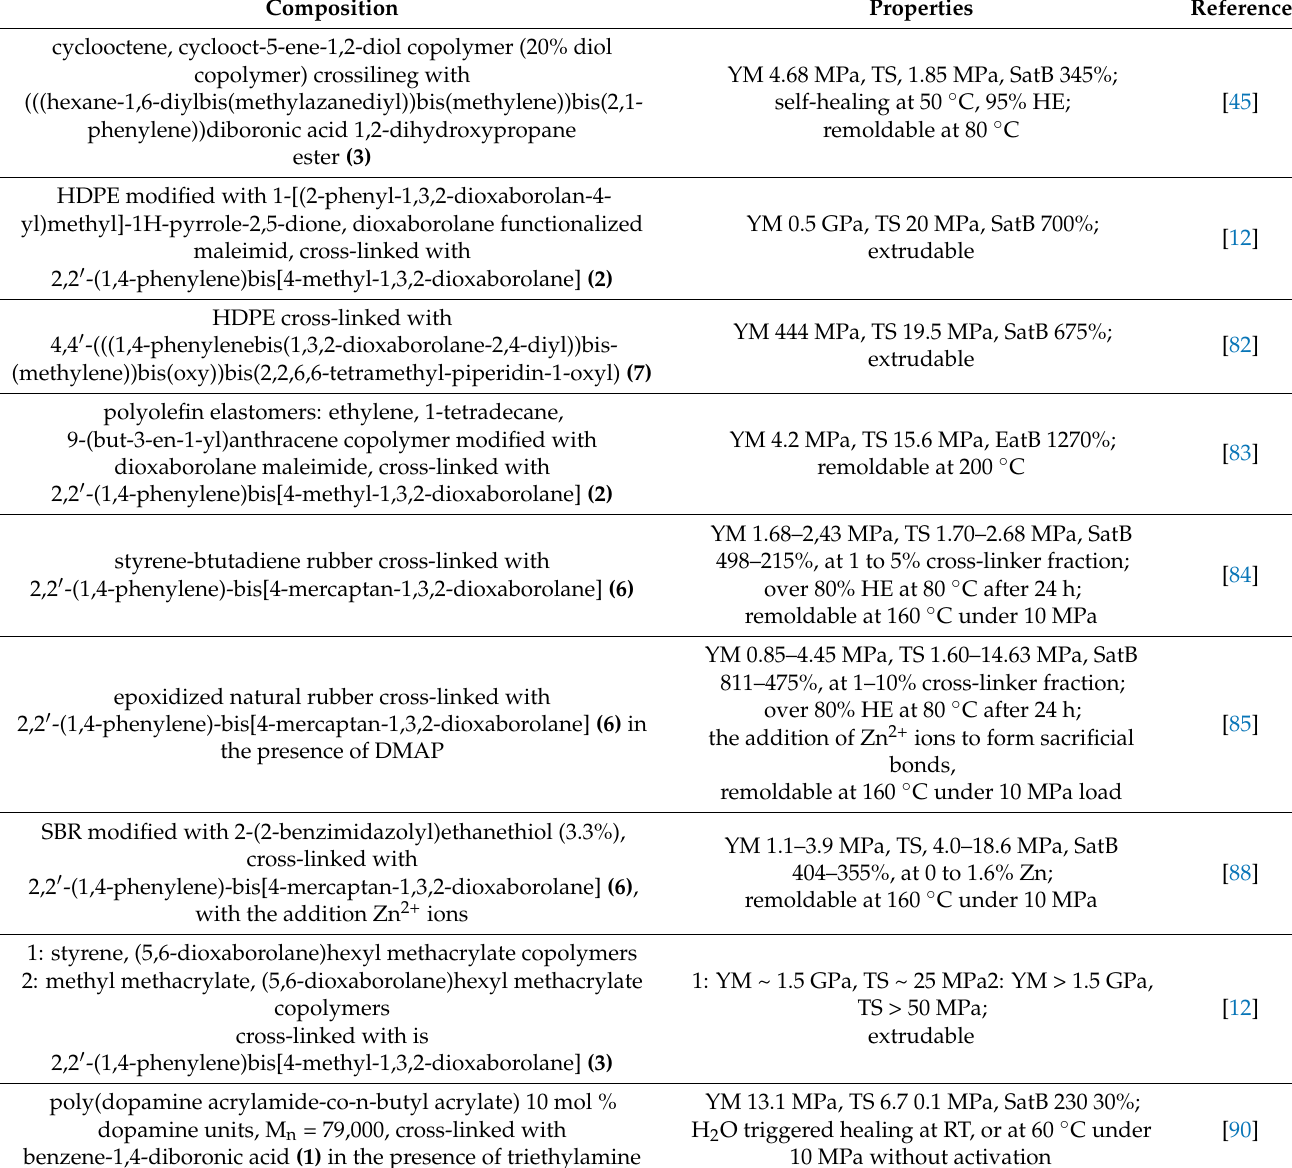
Table 1. An overview of dynamic networks synthesized from various polymers cross-linked using boronic acid esters dynamic